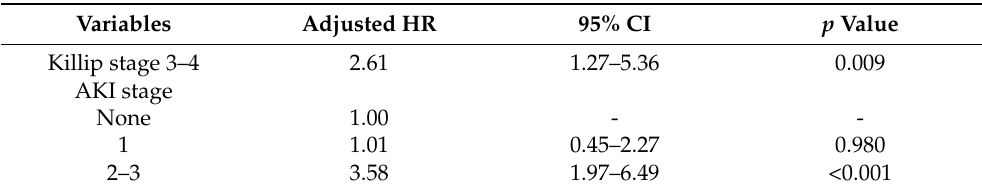
Table 3. Bidirectional stepwise Cox regression analysis for all-cause in-hospital mortality in MI patients.